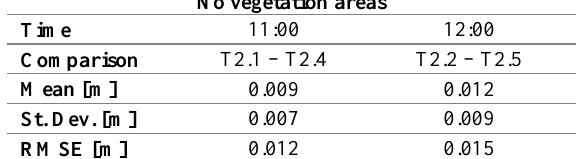
photogrammetric models at the same time of the day with different capturing mode without vegetation